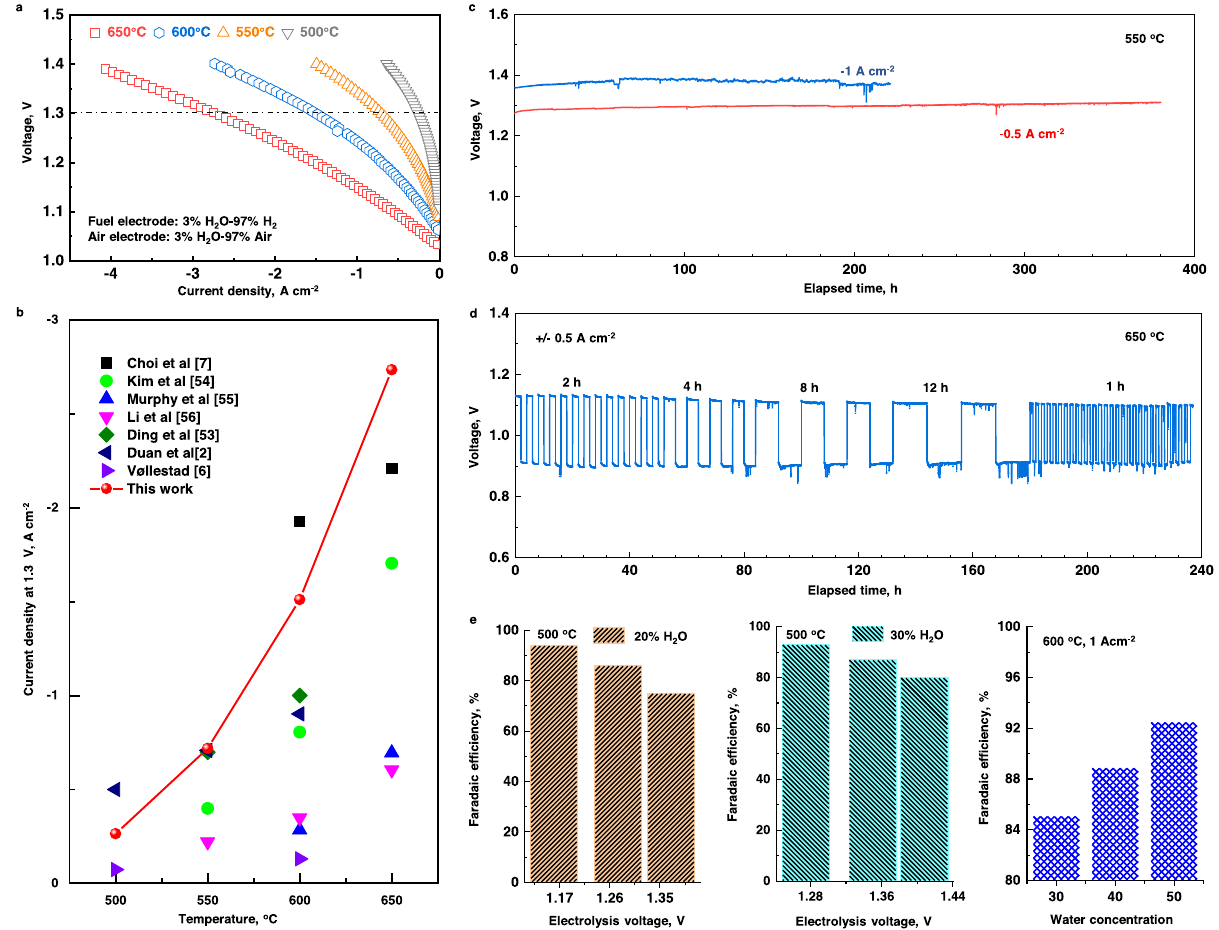
Fig. 4 Electrochemical performance of R-PCECs with the BCFN air electrode in the EL mode. a Typical I-V curves of the R-PCECs measured at 650, 600, 550, and 500 °C, respectively with humidi fi ed H 2 (3% H 2 O) in the fuel electrode and humidi fi ed air (3% H 2 O) in the air electrode in the EL mode; b the comparison of current densities of different air electrode materials reported and this work at 1.3 V from 650 °C to 500 °C; 2,6,7,53 – 56 c Stability test of the single cell at current densities of − 0.5 A cm − 2 and − 1.0 A cm − 2 at 550°C; d Reversible operation of the R-PCEC: the cell voltage as a function of